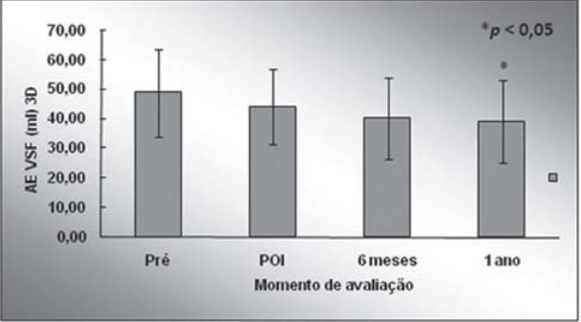
Fig. 4. Evolução do volume sistólico final do átrio esquerdo (AEVSF) durante o estudo. Observamos redução significativa no AEVSF entre o momento 1 ano e POI (pós-operatório imediato). Valores = média ± desvio-padrão. * P < 0,05 em relação ao